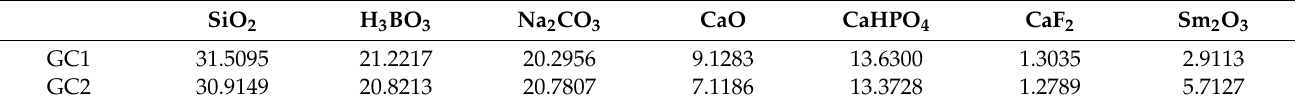
Table 1. The glass-ceramics sample composition in